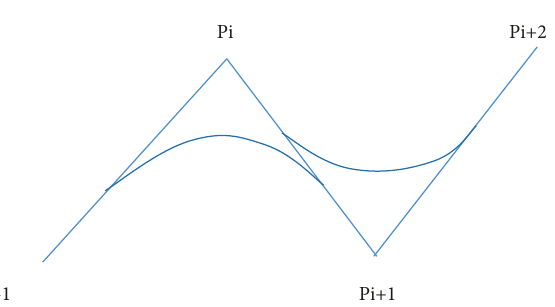
Figure 5: Schematic diagram of transition distance